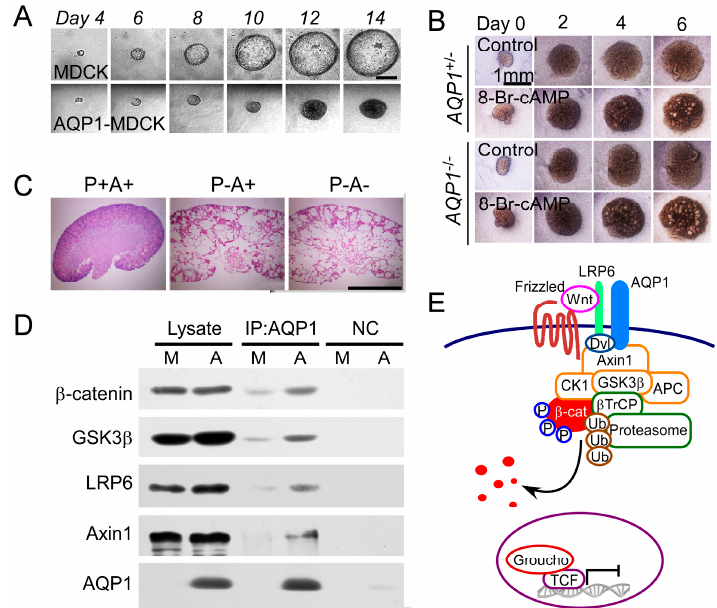
Figure 5. AQP1 retards renal cyst development. A . Representative images of MDCK and AQP1-MDCK cyst from day 4 to day 14. B . Representative images of AQP1 +/ − and AQP1 − / − embryonic kidney cyst from day 0 to day 6. C . Representative images of wild-type, PKD, and AQP1 − / − PKD kidneys. D . Coimmunoprecipitation with anti-AQP1 showing the protein AQP1 interaction with β -catenin, GSK3 β , LRP6, and Axin1 in AQP1-MDCK cells. M and A indicate MDCK cells and AQP1-MDCK cells, respectively. E. Schematic of AQP1 regulating β -catenin (adapted from Ref [79]).